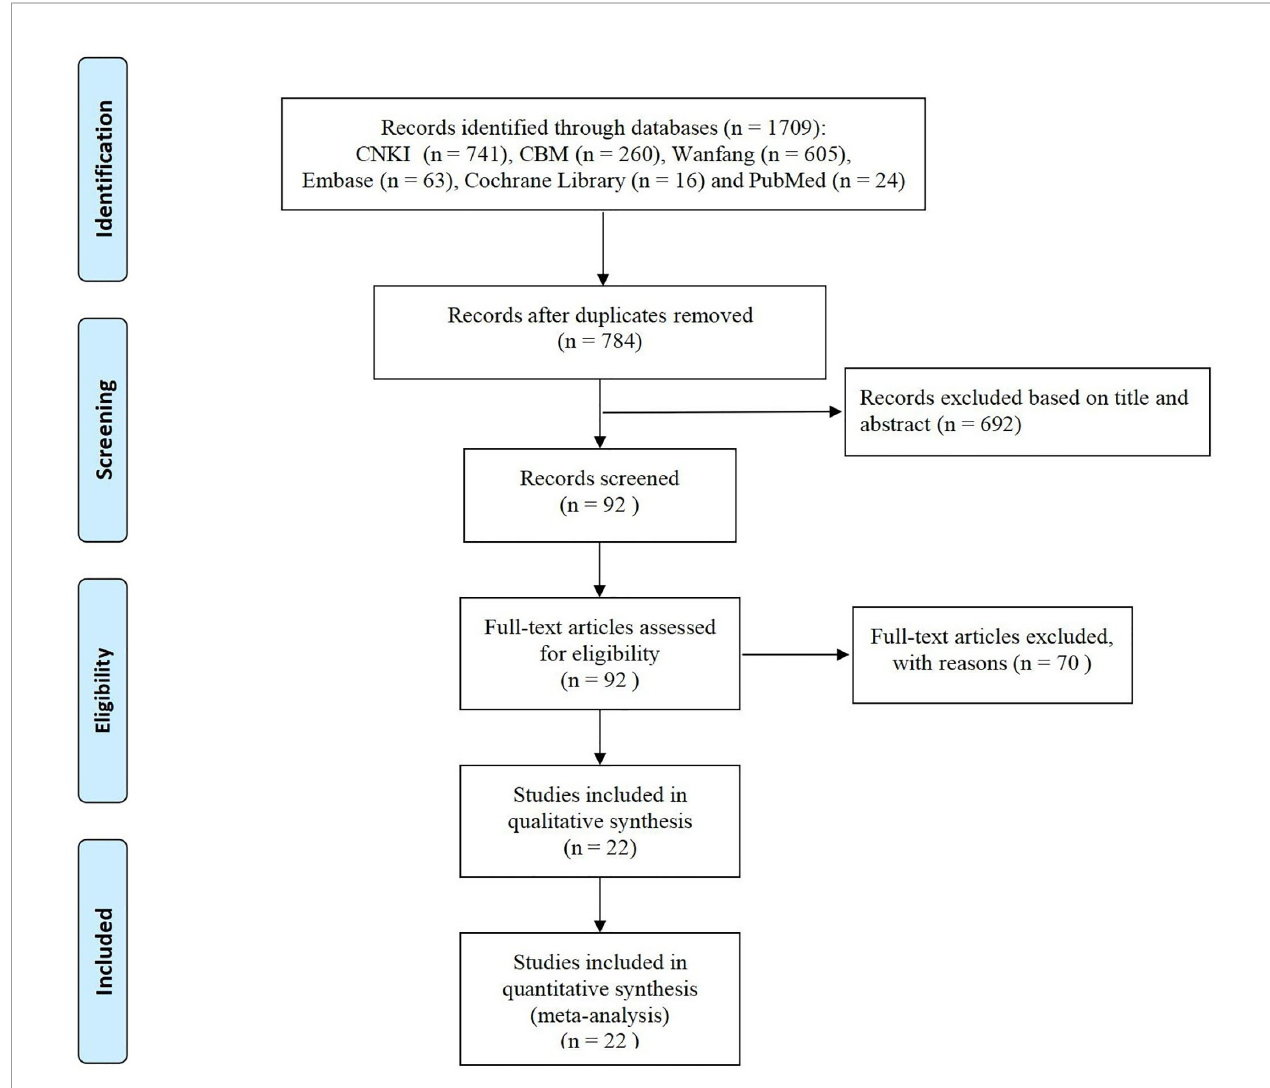
FIGURE 1 | Flow diagram of the study selection